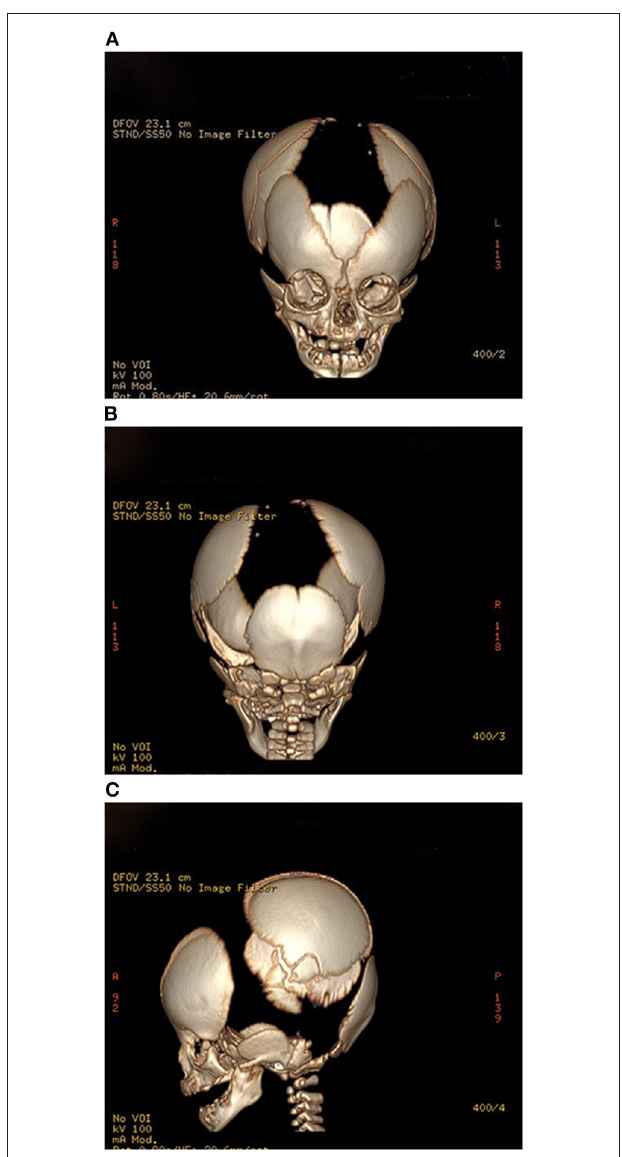
FIGURE 3 | (A–C) Propositus skull CT, frontal, posterior, and lateral views: delayed ossification and wide-open